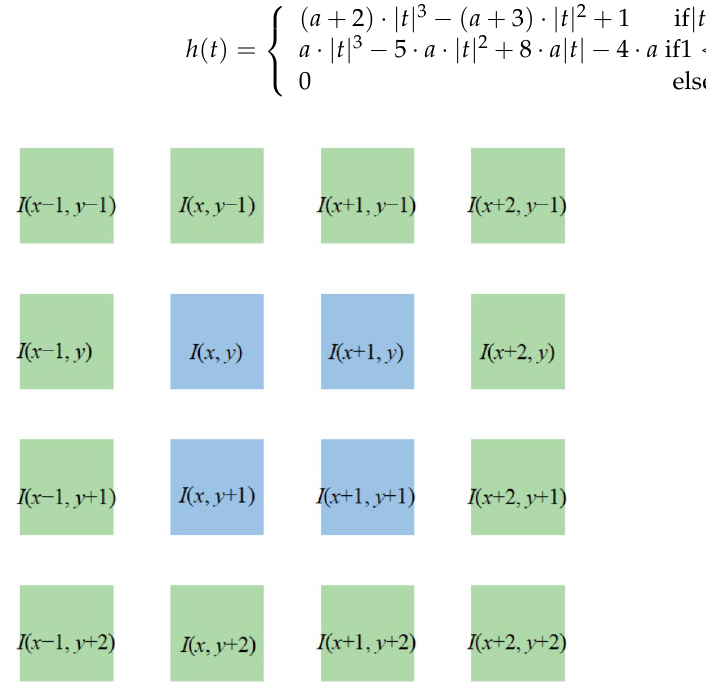
Figure 5. Support pixels for the bicubic interpolation algorithm.